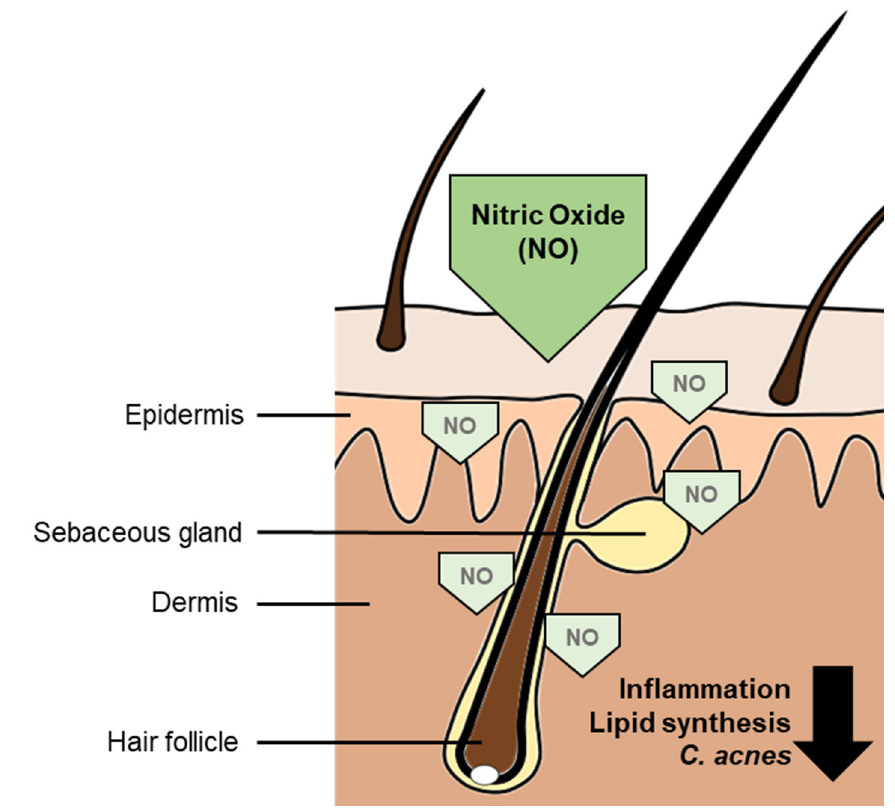
Figure 5. Disease-modifying effects of nitric oxide (NO) on acne vulgaris. The antimicrobial activity leads to a reduction of Cutibacterium acnes colonization. It furthermore reduces inflammation and lipid synthesis, contributing to an improvement of acne vulgaris disease.